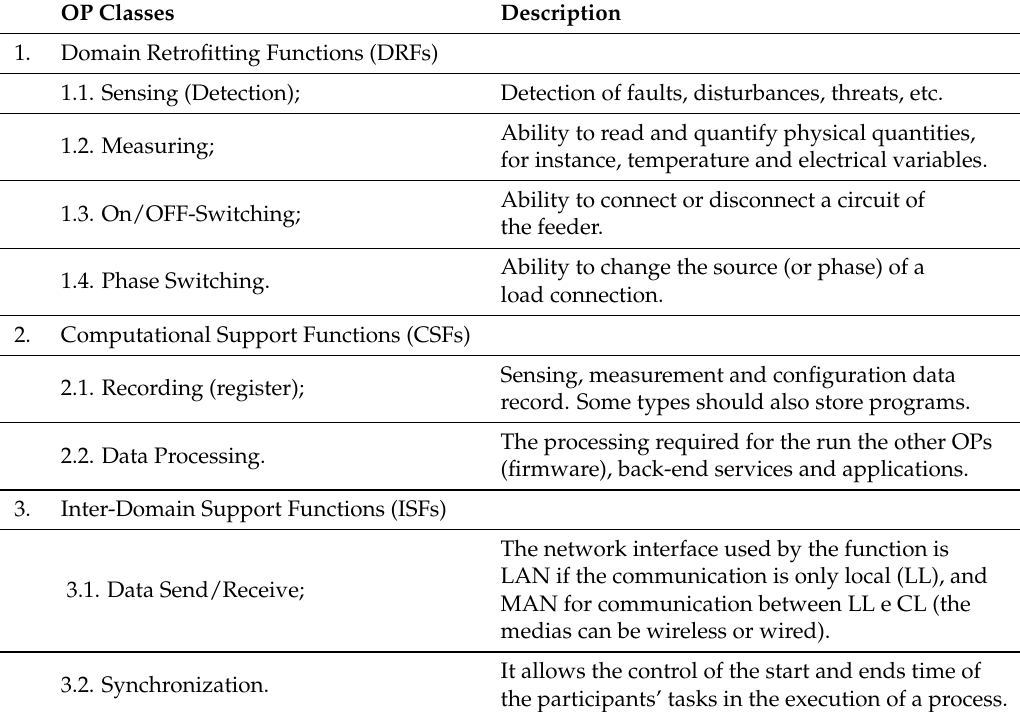
Table 1. The micro-processes, operational primitives (OPs), performed in the layers of SmartLVGrid